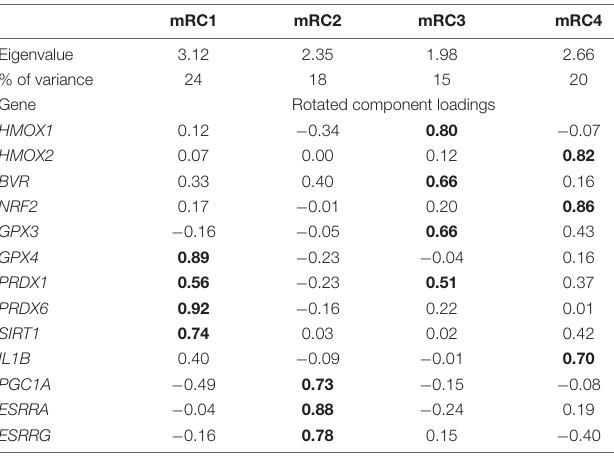
TABLE 1 | Eigenvalues and percent of explained variance for varimax-rotated components mRC1, mRC2, mRC3, and mRC4 that describe expression of genes associated with protection from oxidative stress and lipid peroxidation, production of CO, and mitochondrial biogenesis in skeletal muscle of